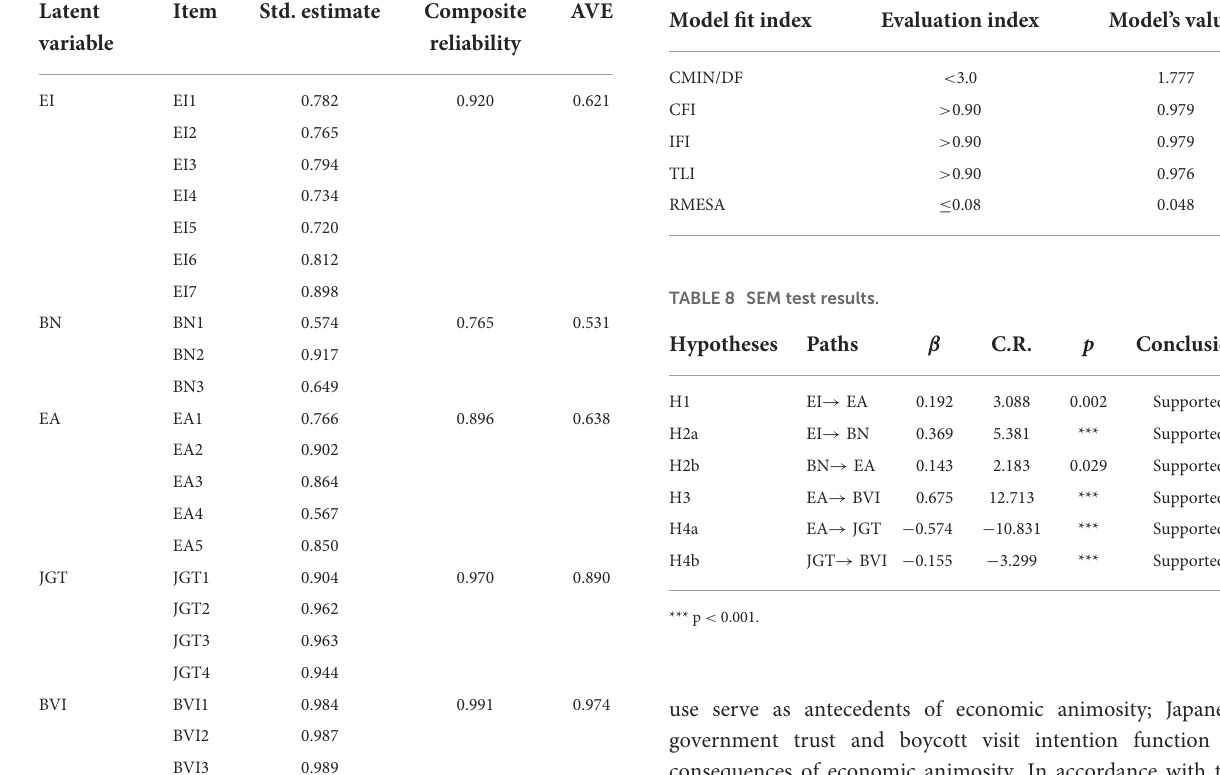
TABLE 5 Convergent validity analysis.